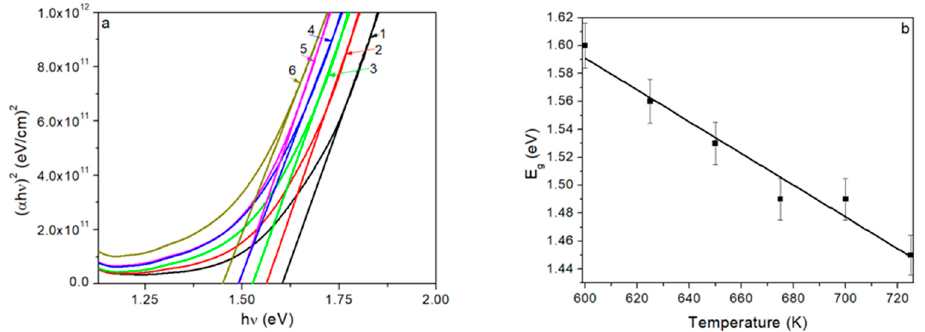
Figure 7. ( a ) The dependences ( α hv ) 2 -( hv ) constructed for CuO thin films obtained at different tem- peratures, T s , K: (1) 600, (2) 625, (3) 650, (4) 675, (5) 700, (6) 725; ( b ) band gap energy variation with the substrate temperature of CuO thin films.